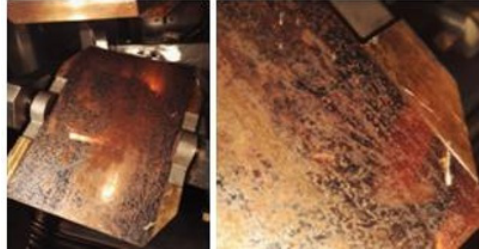
Fig. 14. Contaminations on the steering mirror